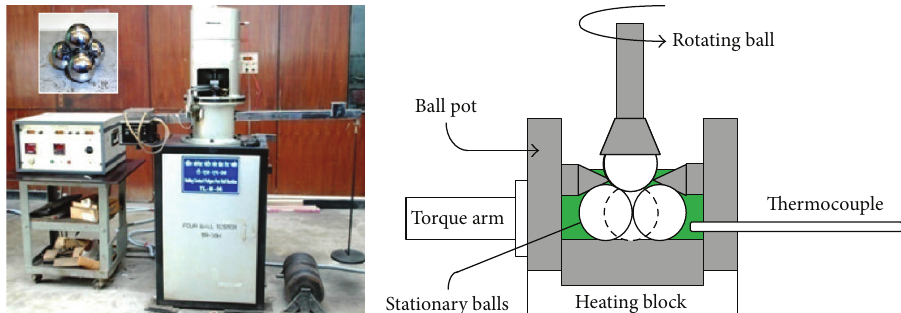
Figure 1: Four-ball tribotester.